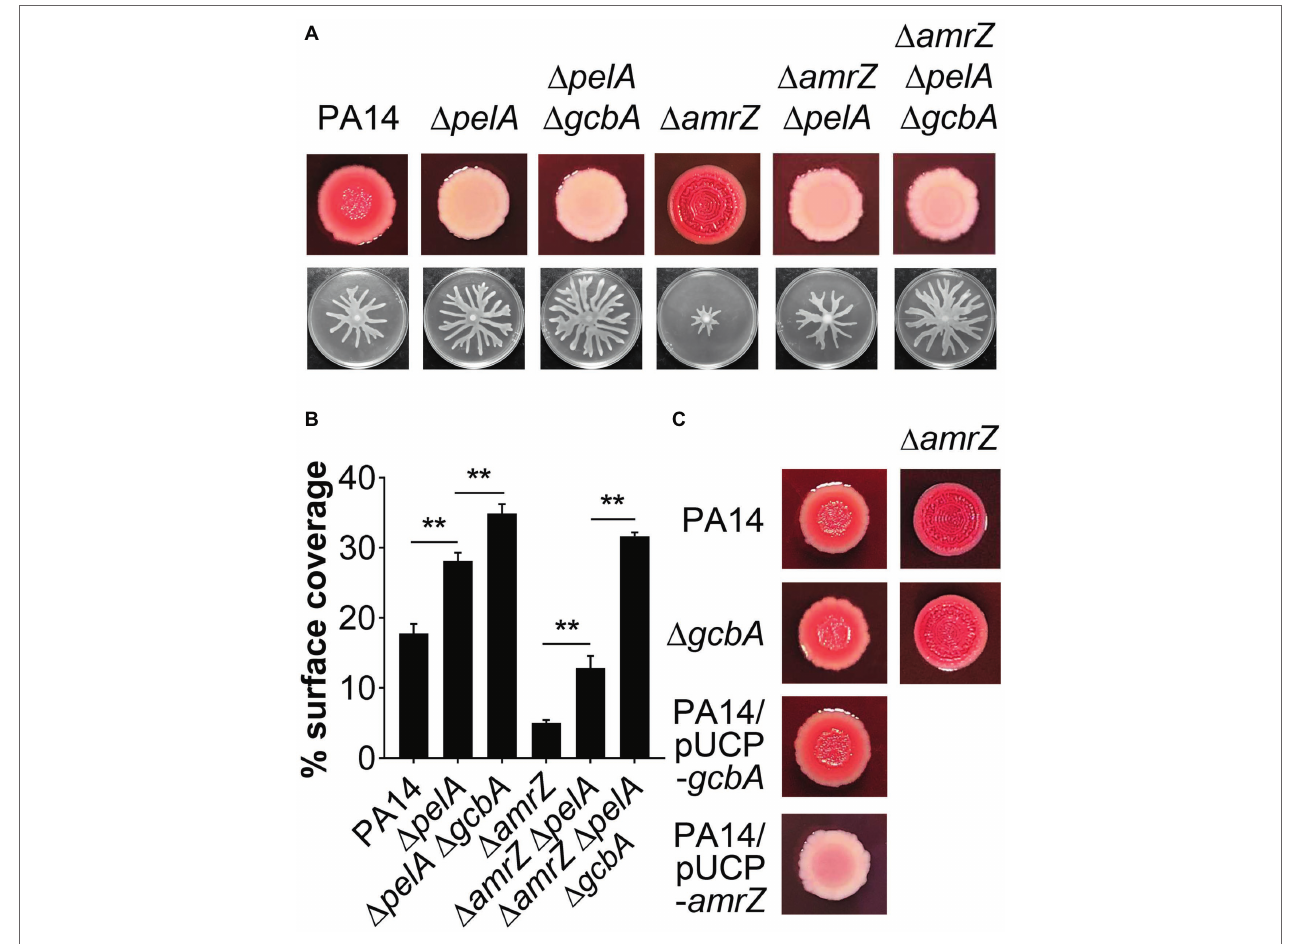
FIGURE 7 | The pel -derived polysaccharide collaborates with GcbA to contribute to the swarming defect of ∆ amrZ . (A) CR binding (upper row) and representative swarm plates (lower row) of the indicated strains. (B) Quantification of the extent of swarming for the strains indicated in (A) . (C) CR-binding phenotypes of the indicated strains. The name of the corresponding strain is indicated on the left. In PA14 and ∆ gcbA additional amrZ mutation was introduced as indicated at the top of the second column. Significance was determined by one-way ANOVA followed by Tukey’s multiple comparison test (** p <